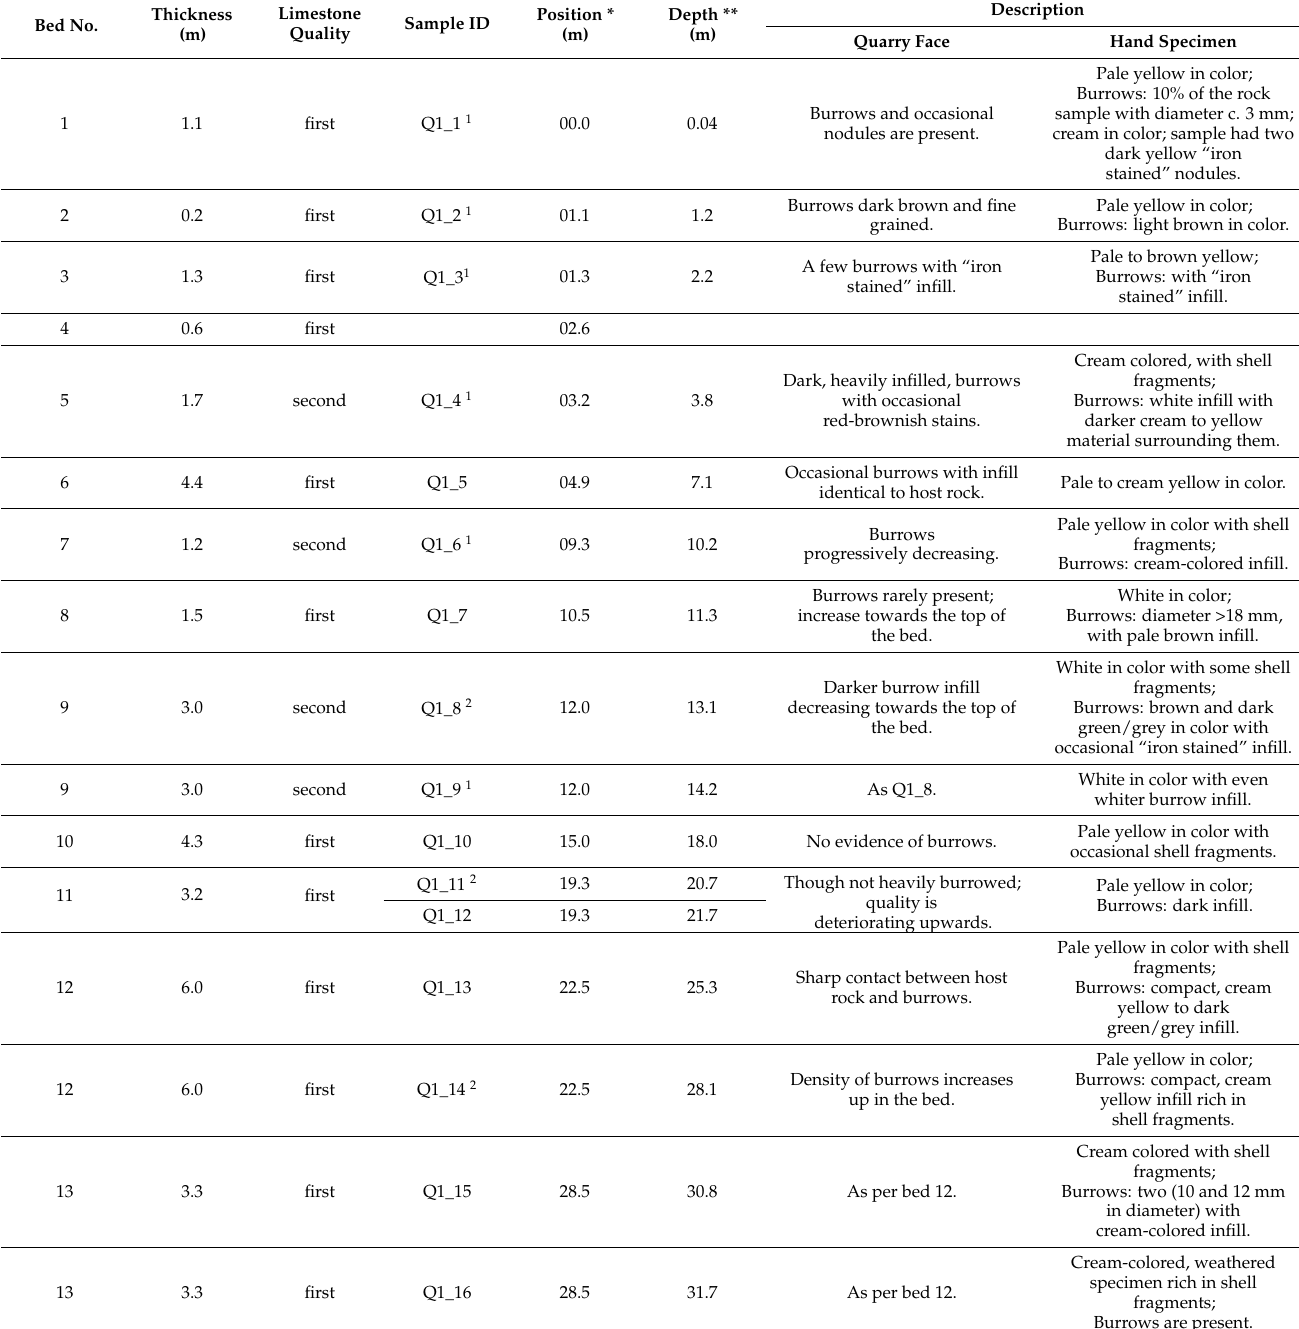
Table 2. Visual description of limestone